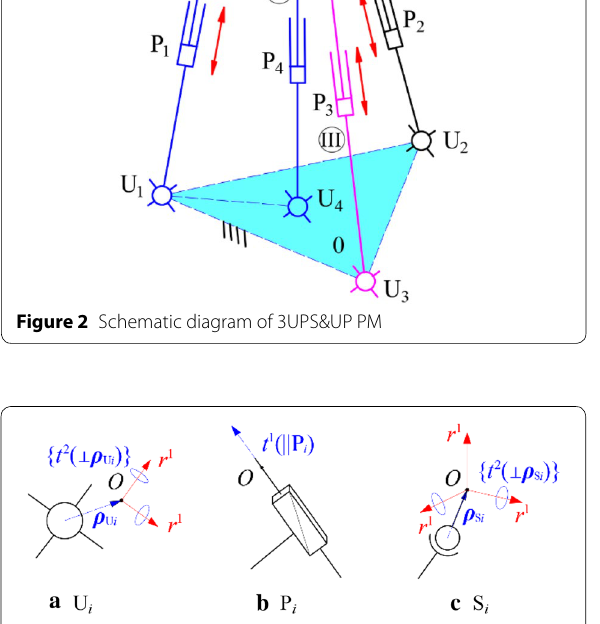
Figure 3 Motion characteristics of U i , P i , and S i